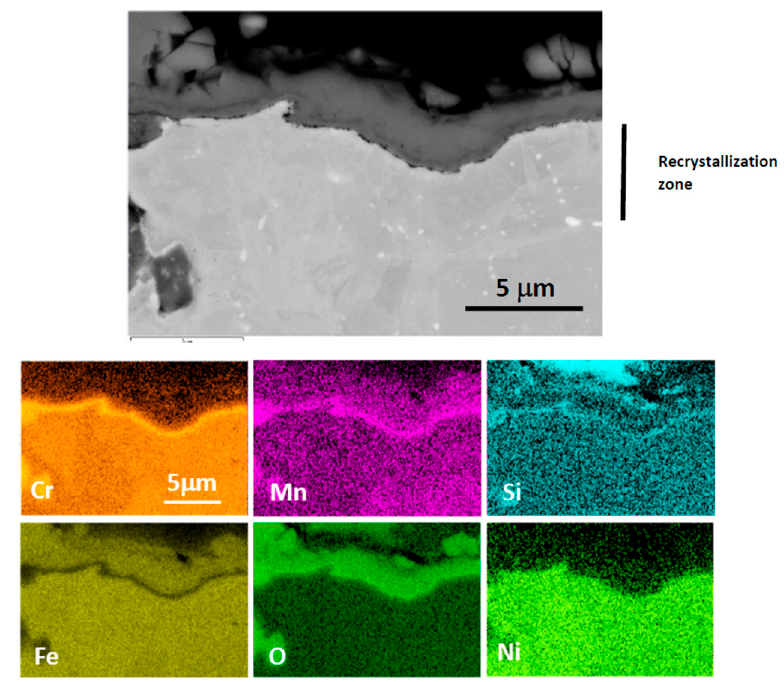
Figure 10. FESEM cross section of the thin oxide formed on HT347HFG exposed to steam at 700 °C under atmospheric pressure after 3000 h.